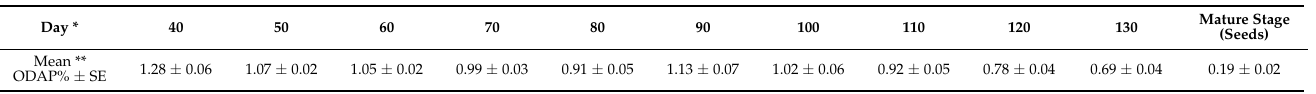
Day * = Sample collection day after sowing ** Mean total ODAP content in leaf of five acceccsions of grass